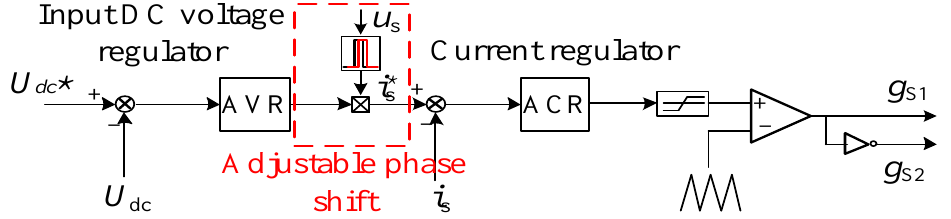
Figure 2. Block diagram of the complementary drive.